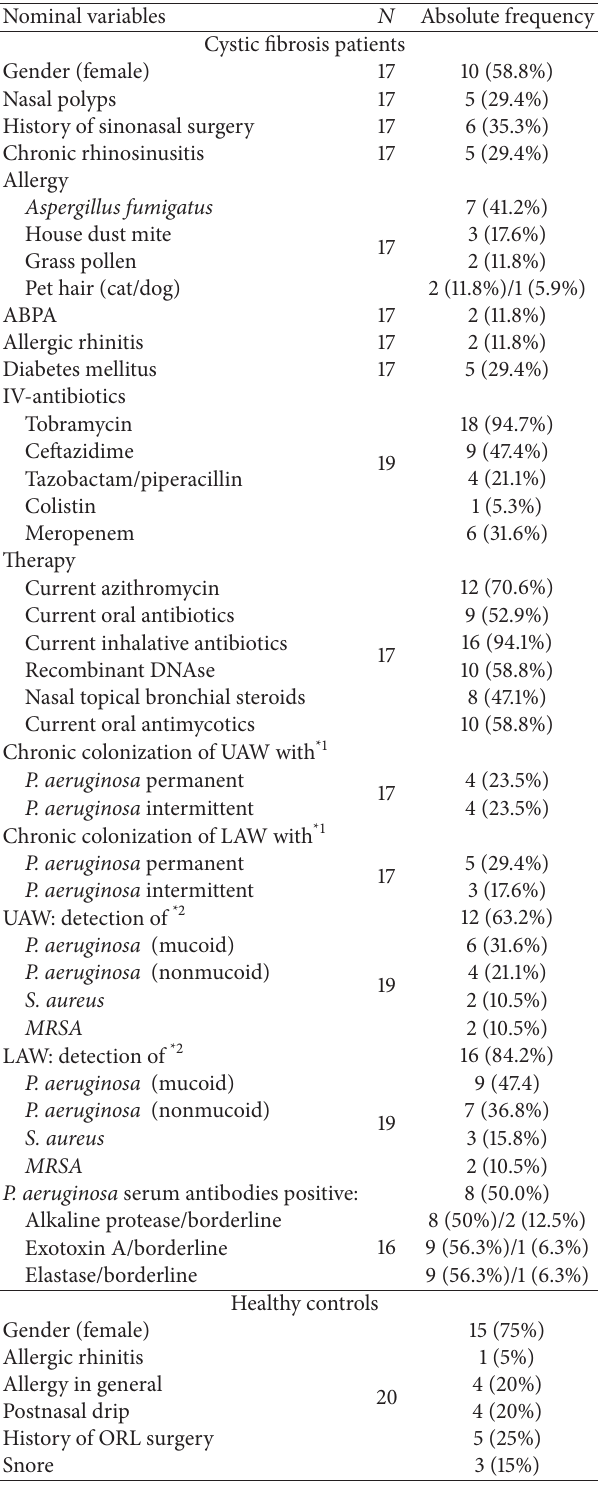
Table 1: Clinical, microbiological, and serological characteristics of included patients and healthy